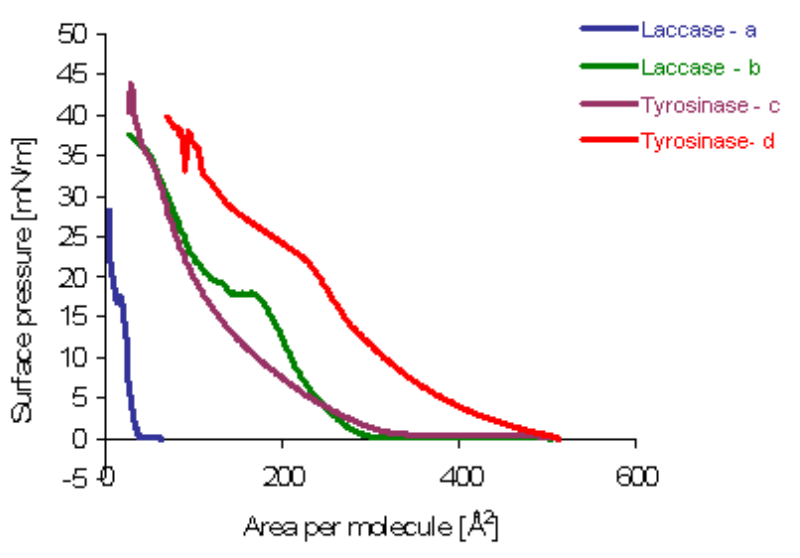
Figure 11. Surface pressure–area isotherms of amphiphilic diphenylamine derivative 4 incorporated film b, c and 4 free film a, d at 22 o C on pure water